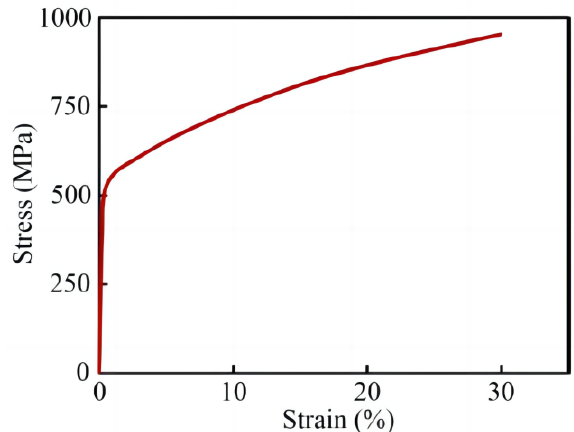
Figure 3. The experimental compressive stress-strain curve of SLM-fabricated dense 316L stainless steel [ 31] .